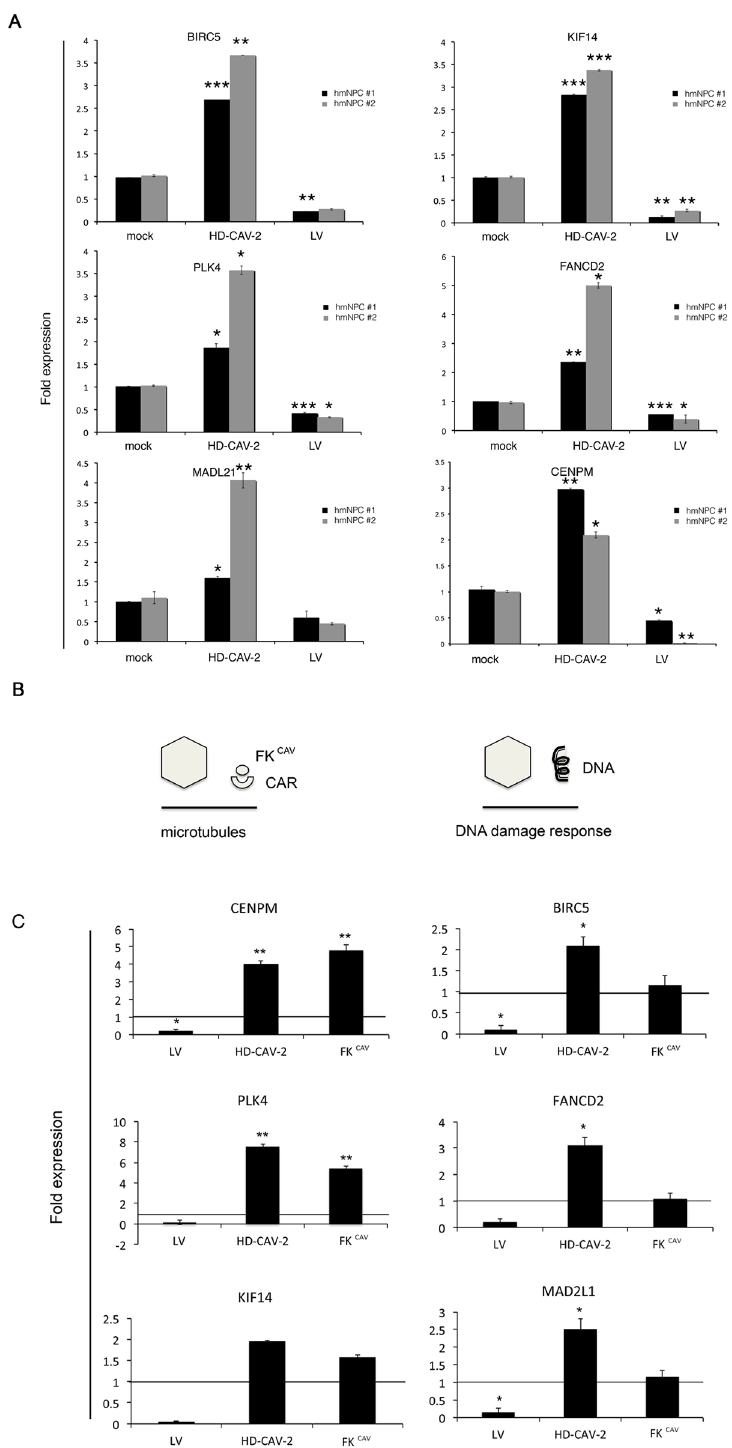
Fig 7. HD-CAV-2 and fibre knob modulate genes related to microtubule metabolism. A) Single gene expression validation by Q-PCR in differentiated neural cells derived from two independent hmNPC batches (#1, BNA and #2, 3821) transduced with HD-CAV-2, LV, mock treated, at 5 days posttransduction. Results are the average of two experiments performed in duplicate. For each gene for the difference between mock and HD-CAV-2 treated cells and between mock and LV treated cells p-values were calculated by Student